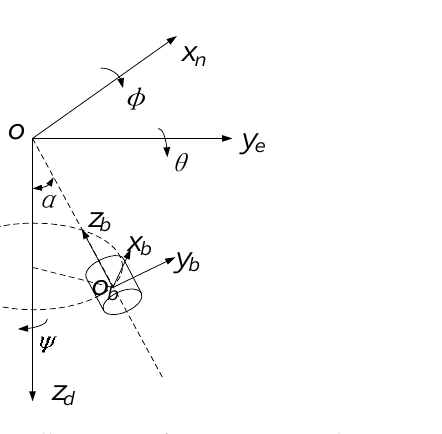
Figure 2. Illustration of navigation coordinate system and projectile coordinate system.